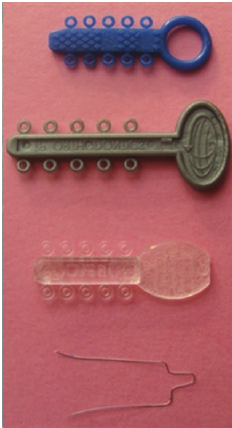
Figure 1: Four types of ligation materials used in the study.